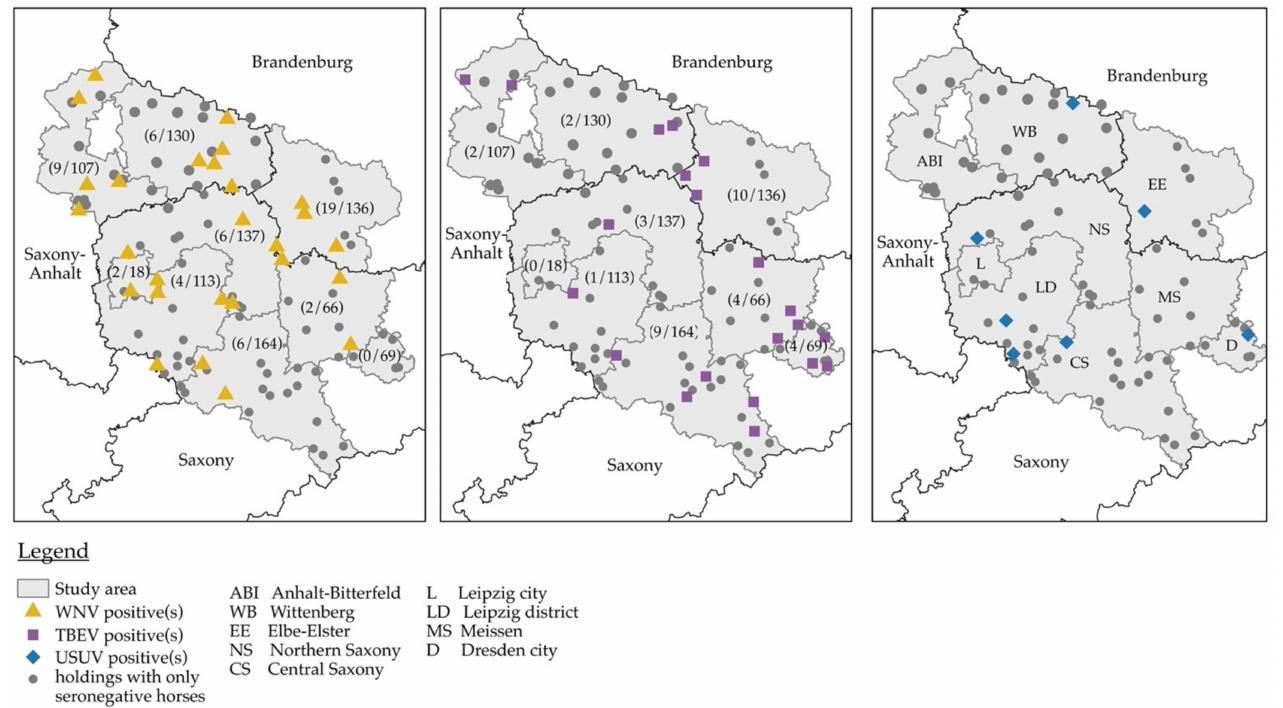
Figure 2. Distribution of seropositive and seronegative horses within the study area. Symbols indicate holdings that can house one or more seropositive horse(s). The numbers in brackets indicate the number of seropositive horses for WNV and TBEV per total number of samples in the respective county. For USUV, each symbol indicates one seropositive horse sample, except for Dresden, where two seropositive horses originated from one